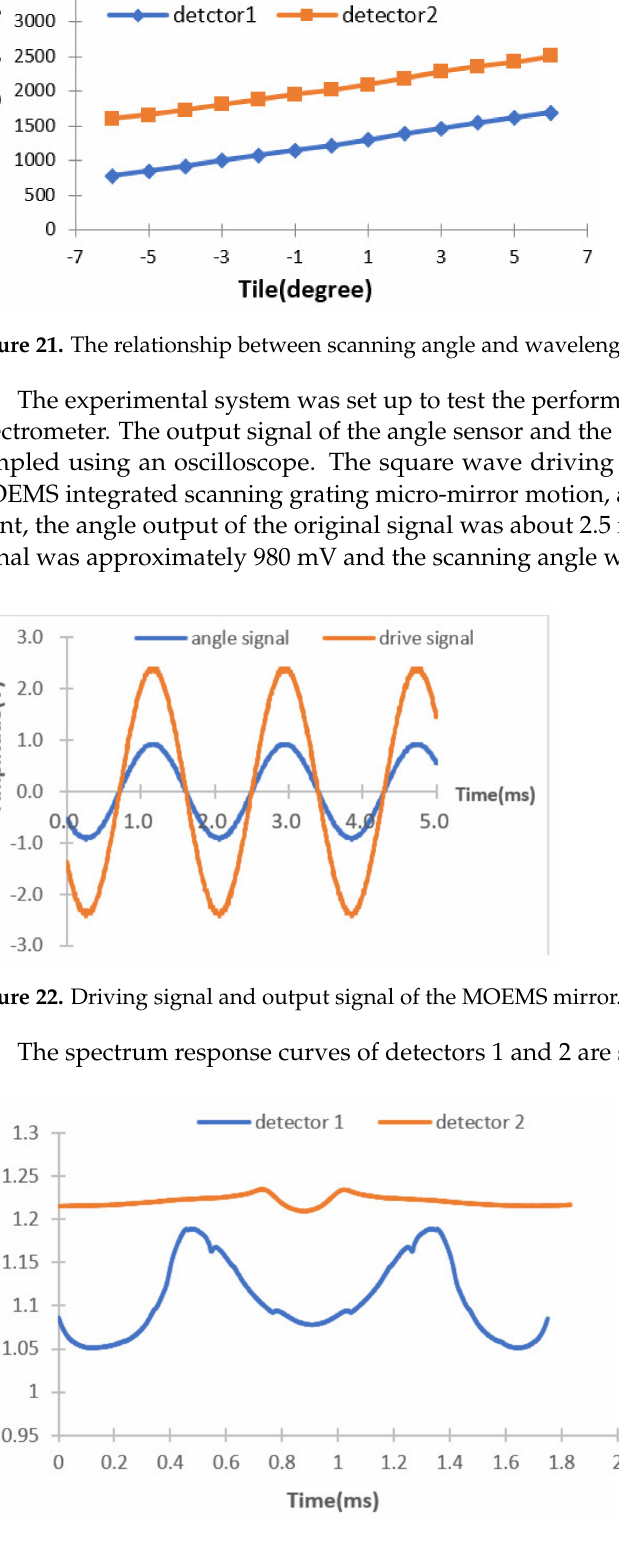
Figure 23. Spectrum signal of detector 1 and detector